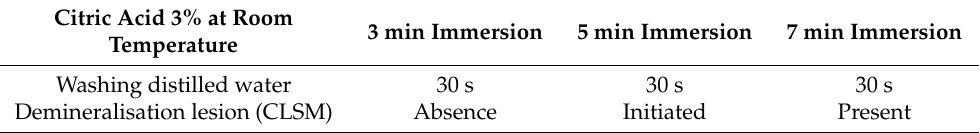
Table 1. Protocol of in vitro demineralisation after CLSM